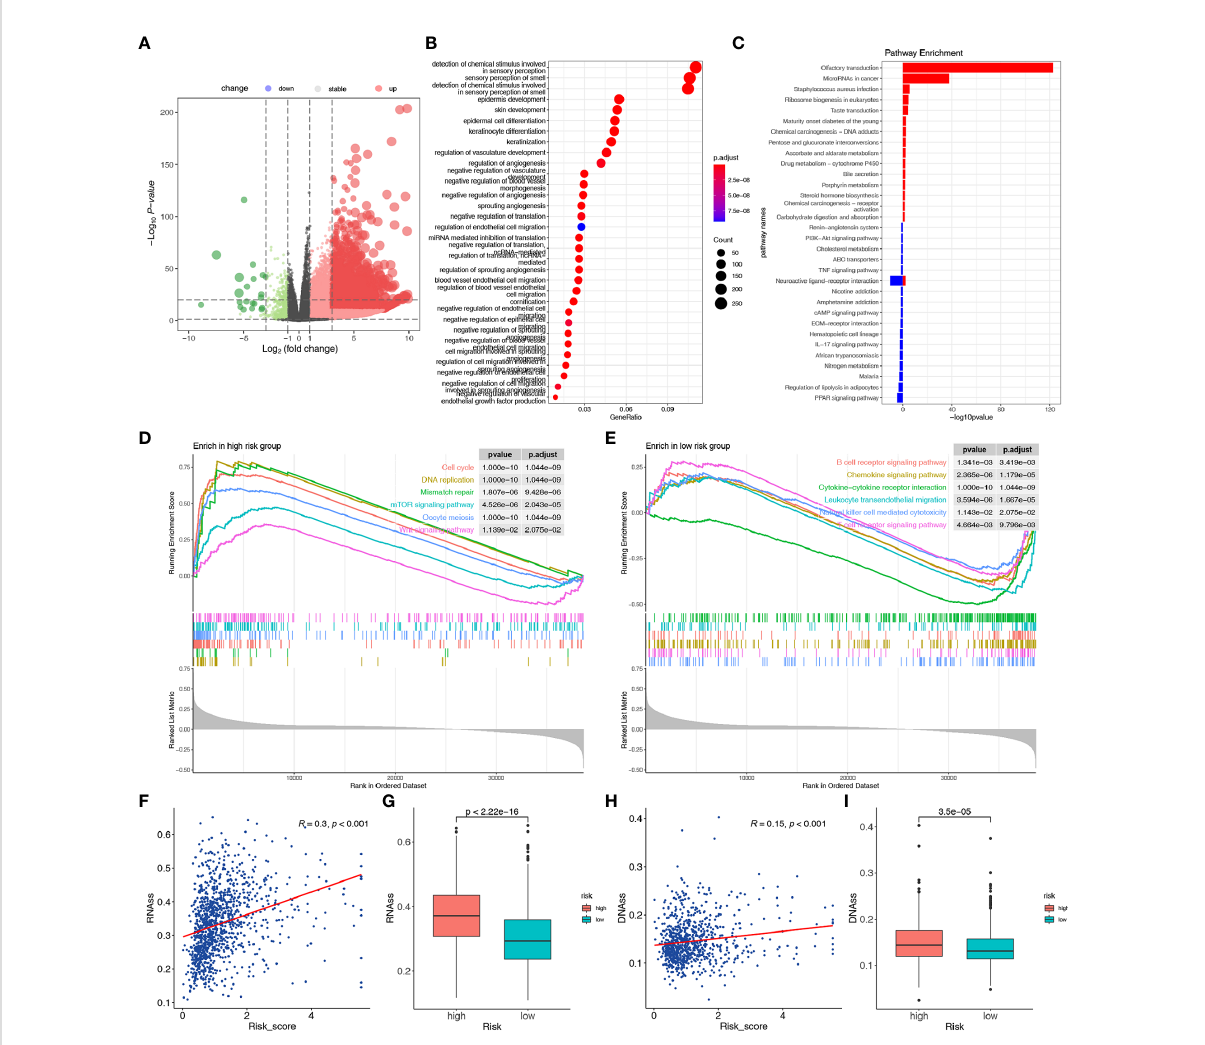
FIGURE 6 Functional enrichment, stemness, and m6A modi fi cation-related analyses between the two risk groups. (A) The volcano plot of the DEGs between the high-risk and low-risk groups. (B) The GO analysis of the DEGs. (C) The KEGG analysis of the DEGs. The pathways enriched in the high-risk (D) and low-risk (E) groups according to the GSEA. (F) The relationship between risk score and RNAss. (G) Differences in RNAss between the two risk groups. (H) The relationship between risk score and DNAss. (I) Differences in DNAss between the two risk